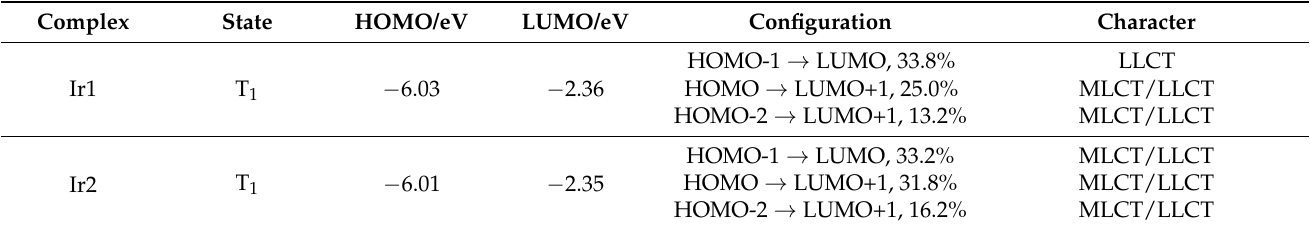
Figure 3. The distributions of molecular orbitals of Ir1 and Ir2. Table 2. The theoretical calculation of molecular orbitals of Ir1 and